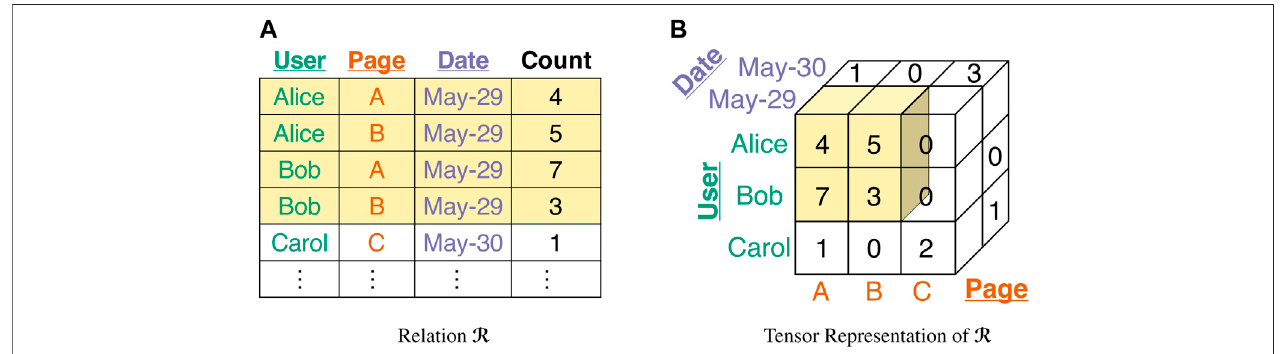
FIGURE 2 | Pictorial description of Example 1. (A) Relation R where the colored tuples compose relation B . (B) Tensor representation of R where the relation B forms a